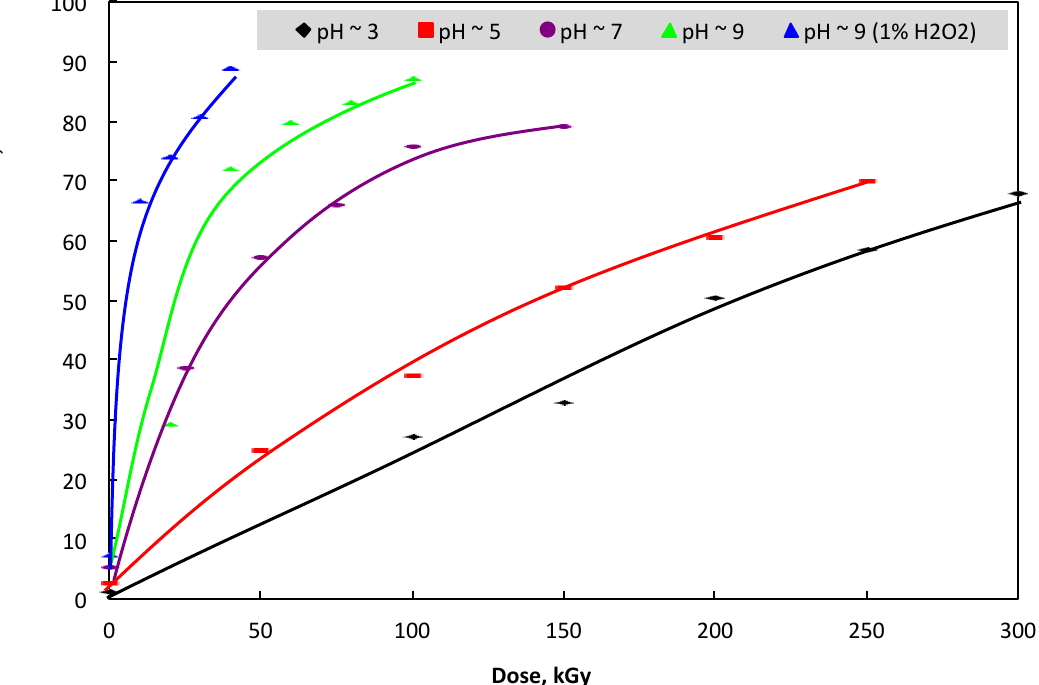
Figure 1. The increase in water-soluble content in β -glucan by gamma irradiation at various conditions.